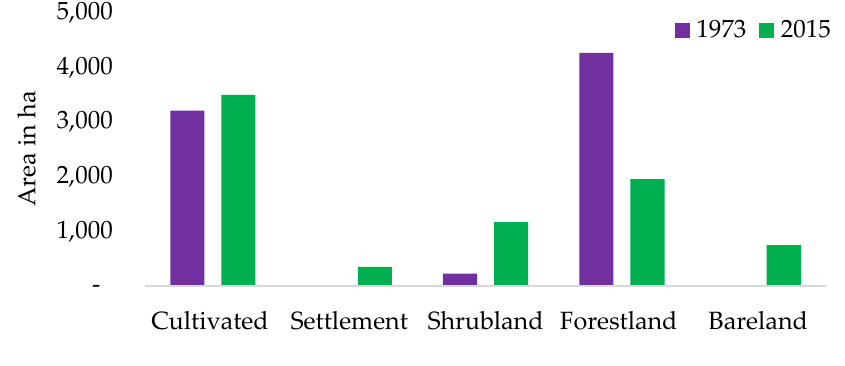
Figure 4. Changes in LULC from 1973 to 2015 in Chillimo forest, Ethiopia (Source of data: Tolessa et al. [5], but figure done by authors).